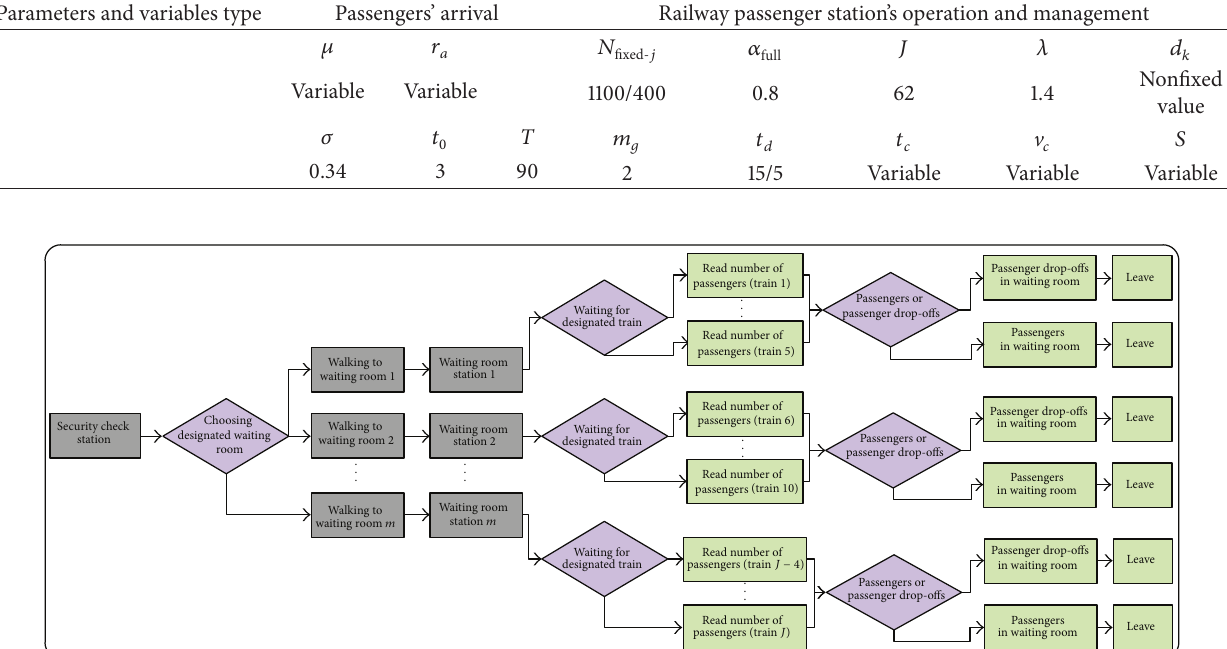
Figure 6: Waiting and departure